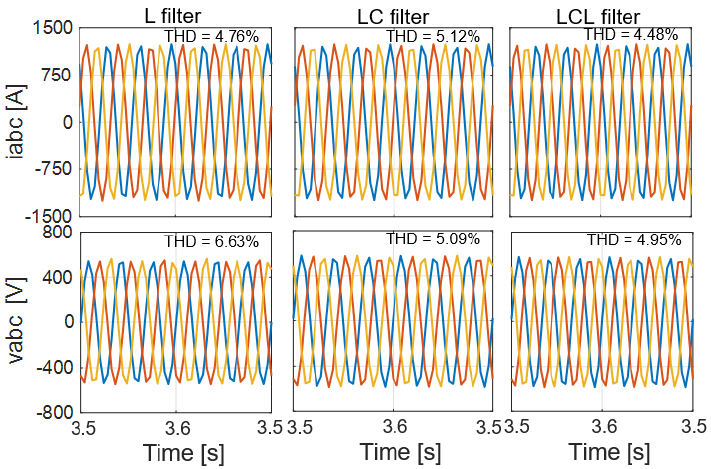
Figure 11. Voltage and current output with THD values for L, LC, and LCL filters.